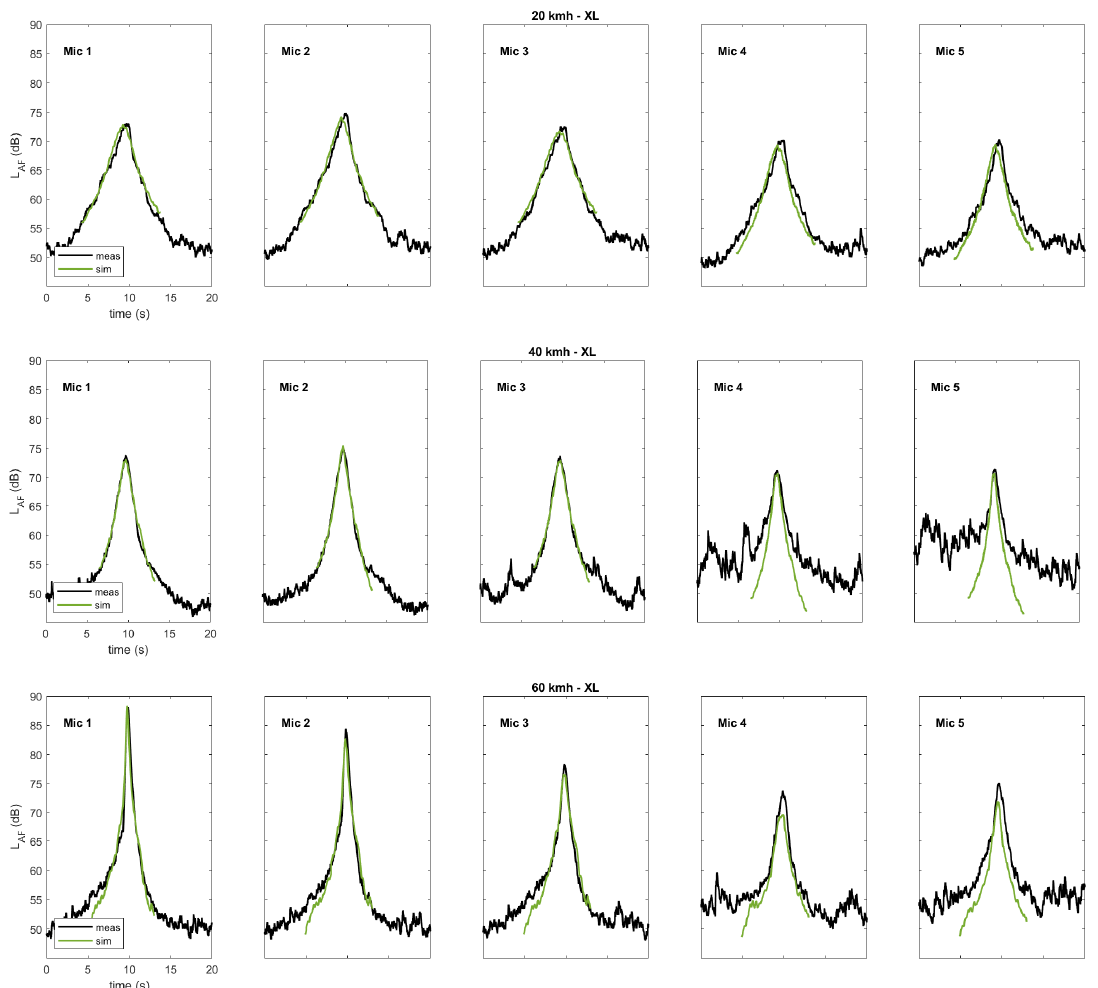
Figure 9. Comparison of measured vs. simulated A-weighted sound pressure level time histories for exemplary flights of the XL multicopter at three different velocities, shown for all microphones.